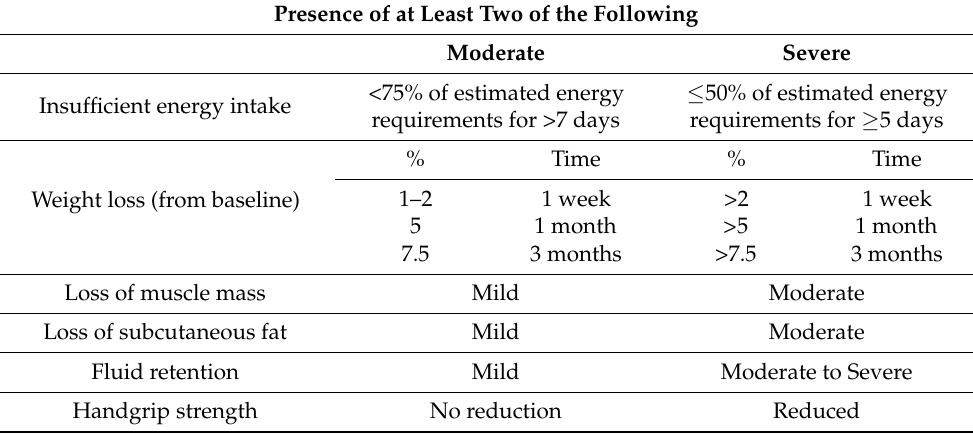
Table 2. Diagnostic criteria for malnutrition in the context of acute illness or injury, according to the American Society of Parenteral and Enteral Nutrition [14].